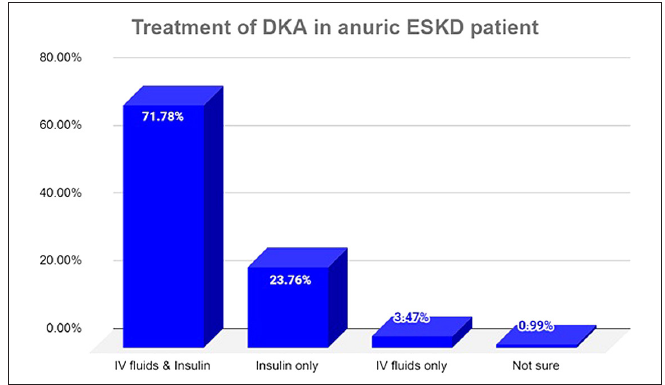
Figure 2. Treatment of DKA in anuric ESKD patient. ESKD, end-stage kidney disease; DKA, diabetic ketoacidosis.